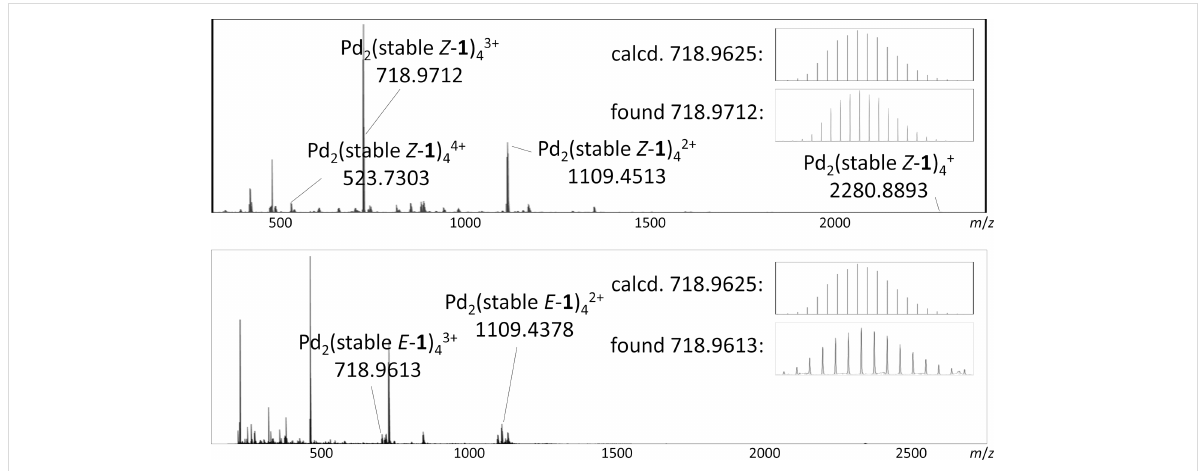
Figure 3: HRMS spectra of cage complex Pd 2 (stable Z - 1 ) 4 (top) and cage complex Pd 2 (stable E - 1 ) 4 (bottom); Insets: comparison of simulated and measured isotopic patterns of Pd 2 L 4 (NO 3 ) 3+ ions.